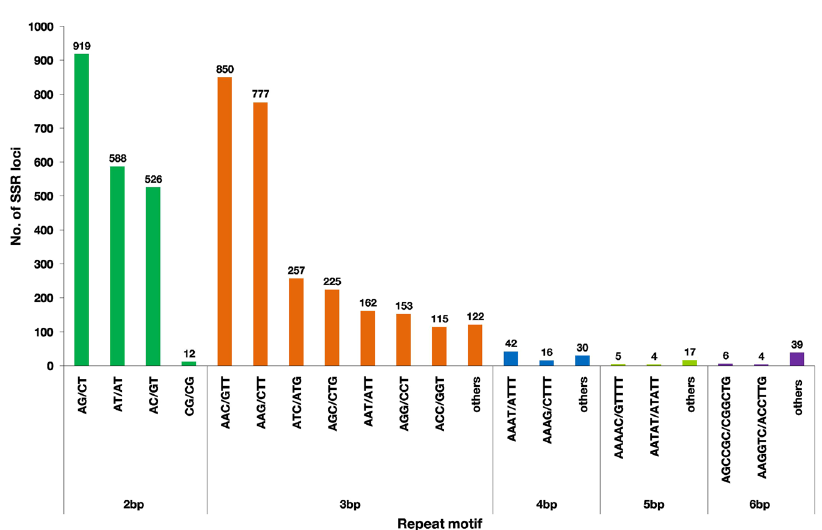
Figure 7. Summary of SSR types identified in Solanum trilobatum leaf transcriptome.